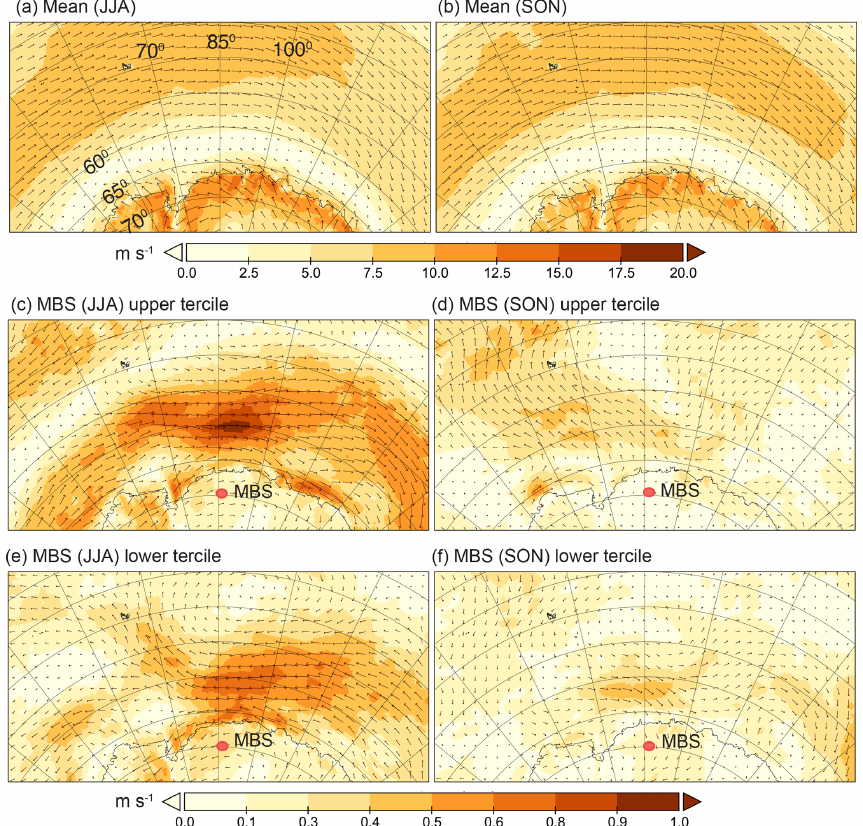
Figure 9. Near-surface (10m) wind vector composite maps of the mean state during austral winter ( a , June–August) and spring ( b , September–November) and anomaly composite maps during the upper (c) and lower (e) tercile in June–August of the detrended, log- transformed annual sea salt concentrations from the Mount Brown South (MBS) site average, over the period 1979–2016. (d, f) The same as (c) and (e) except in September–November. The red dot indicates the MBS site location. Latitudinal lines are in increments of 5 ◦ , and longitudinal lines are in increments of 15 ◦